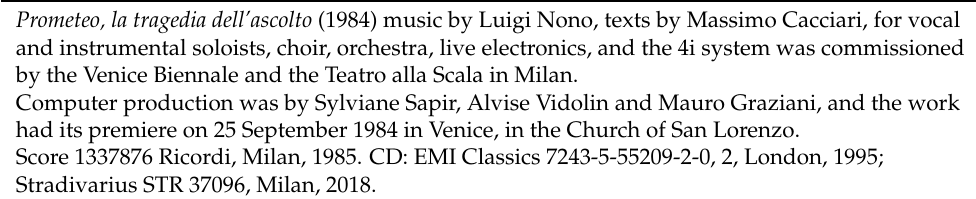
Table 1. Luigi Nono: Prometeo, tragedia dell’ascolto .